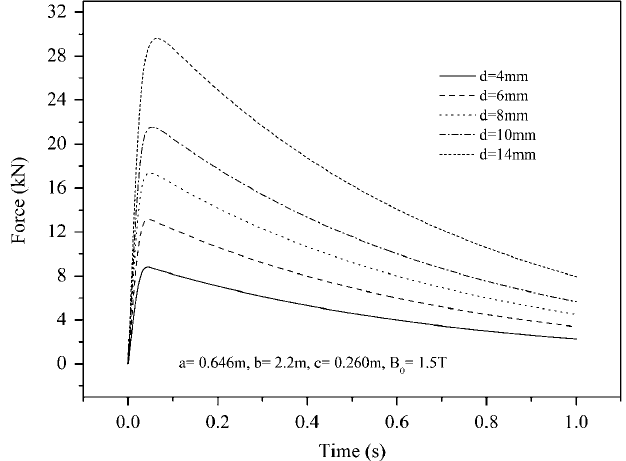
FIG. 15. Variation of the force (in kN) on a chamber with time for different wall thickness ( d ¼ 4 , 6, 8, 10, and 14 mm) of a chamber when exposed to a nonuniform time varying magnetic field.